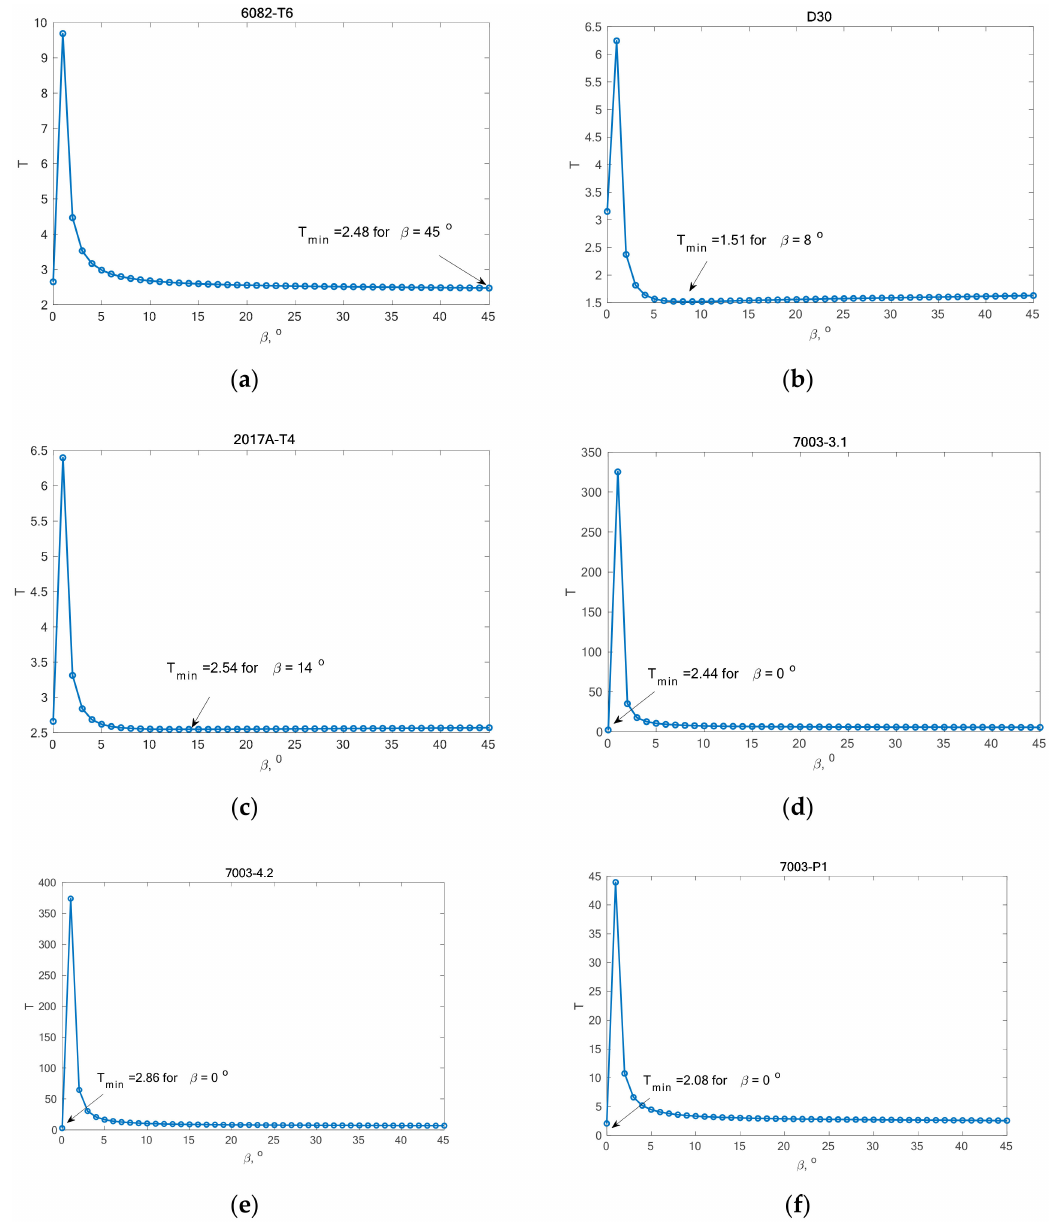
Figure 5. The correlation between T scatter and the β angle for the analyzed aluminium alloys: ( a ) 6082-T6; ( b ) D30; ( c ) 2017A-T4; ( d ) 7003-3.1; ( e ) 7003-4.2; ( f )